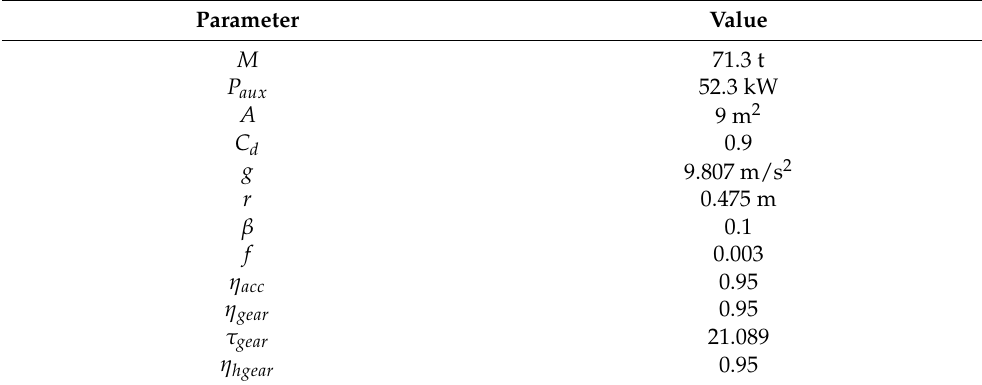
Table 2. Input parameters regarding vehicle characteristics.